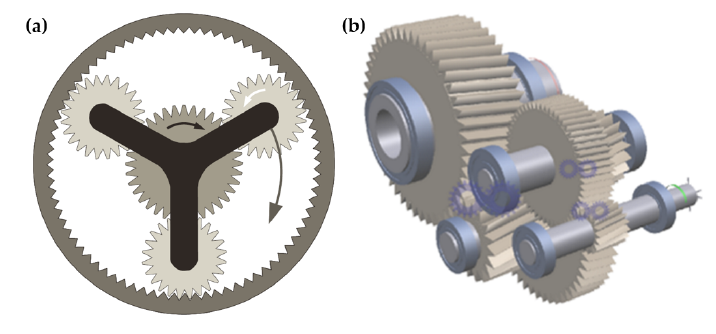
Figure 3. Schematic of ( a ) a planetary gear set and ( b ) a multi-stage gear